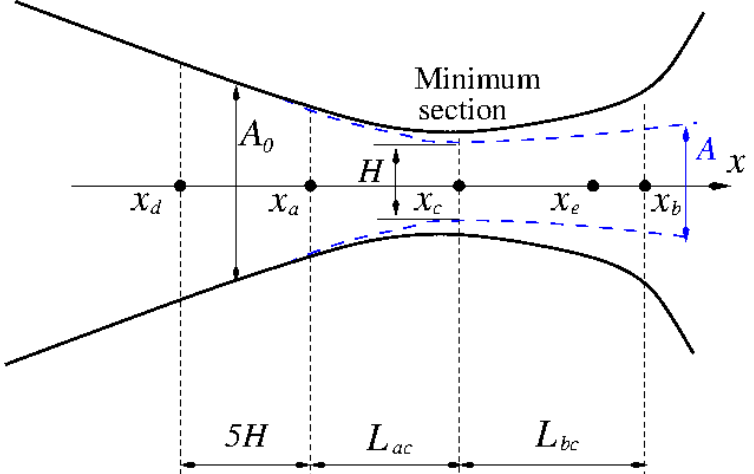
Figure A1. Schematic for the 1D pulsatile flow model, where the characteristics of vocal fold are described by a simple 2D converging-diverging channel. Here x c is the narrowest section, x a is an inferior location, x b is the glottal exit, x e is an intermediate location in the diverging section, and x d is a subglottal